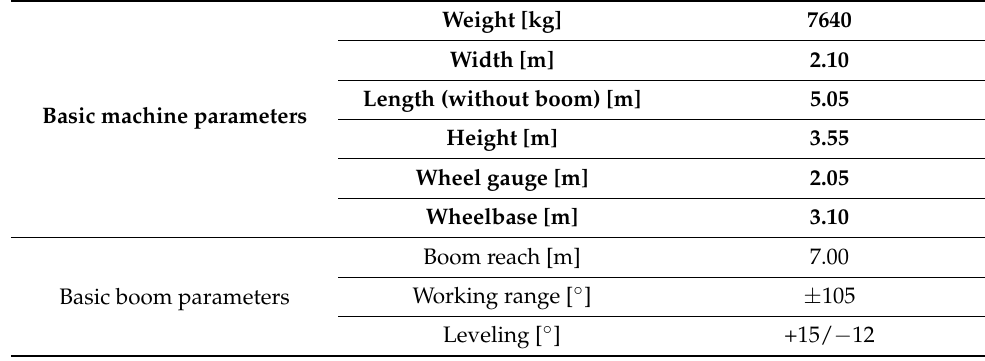
Figure 2. Harvester AH6 made by Agama a.s. Table 1. Parameters of the AH6.